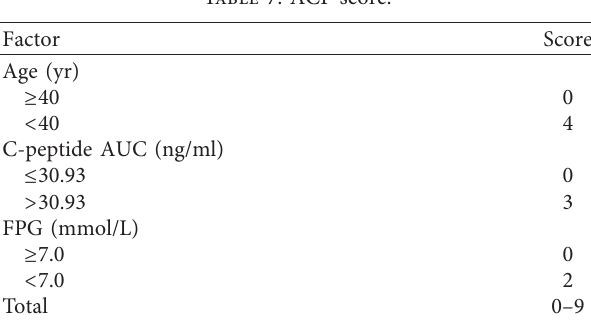
Table 7: ACF score.